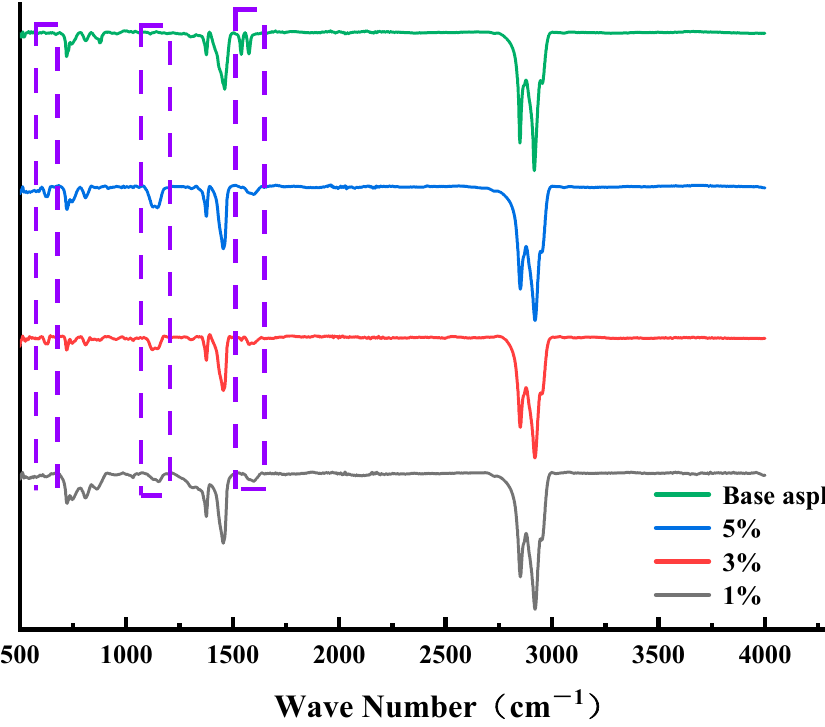
Figure 2. Infrared spectra of biomass asphalt/water emulsion with different emulsifier contents (The purple dashed line represents the main characteristic peak changes occurring in the emulsified asphalt relative to the matrix asphalt).